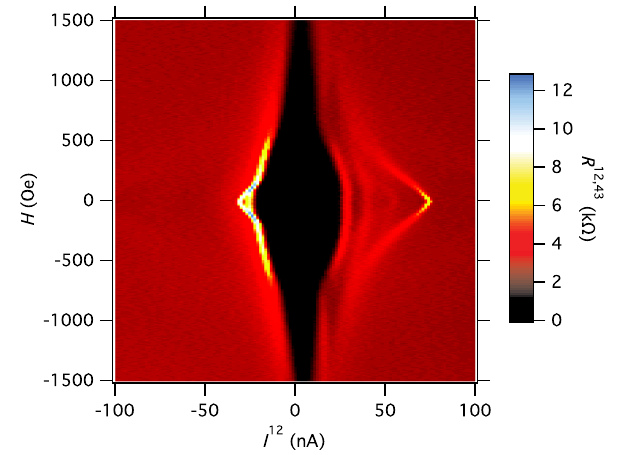
FIG. 4. Nonlocal differential resistance dependence of the driving current and external out-of-plane magnetic field for device C. Nonlocal resistance is numerically extracted from a series of I - V curves similar to Fig. 2(b).